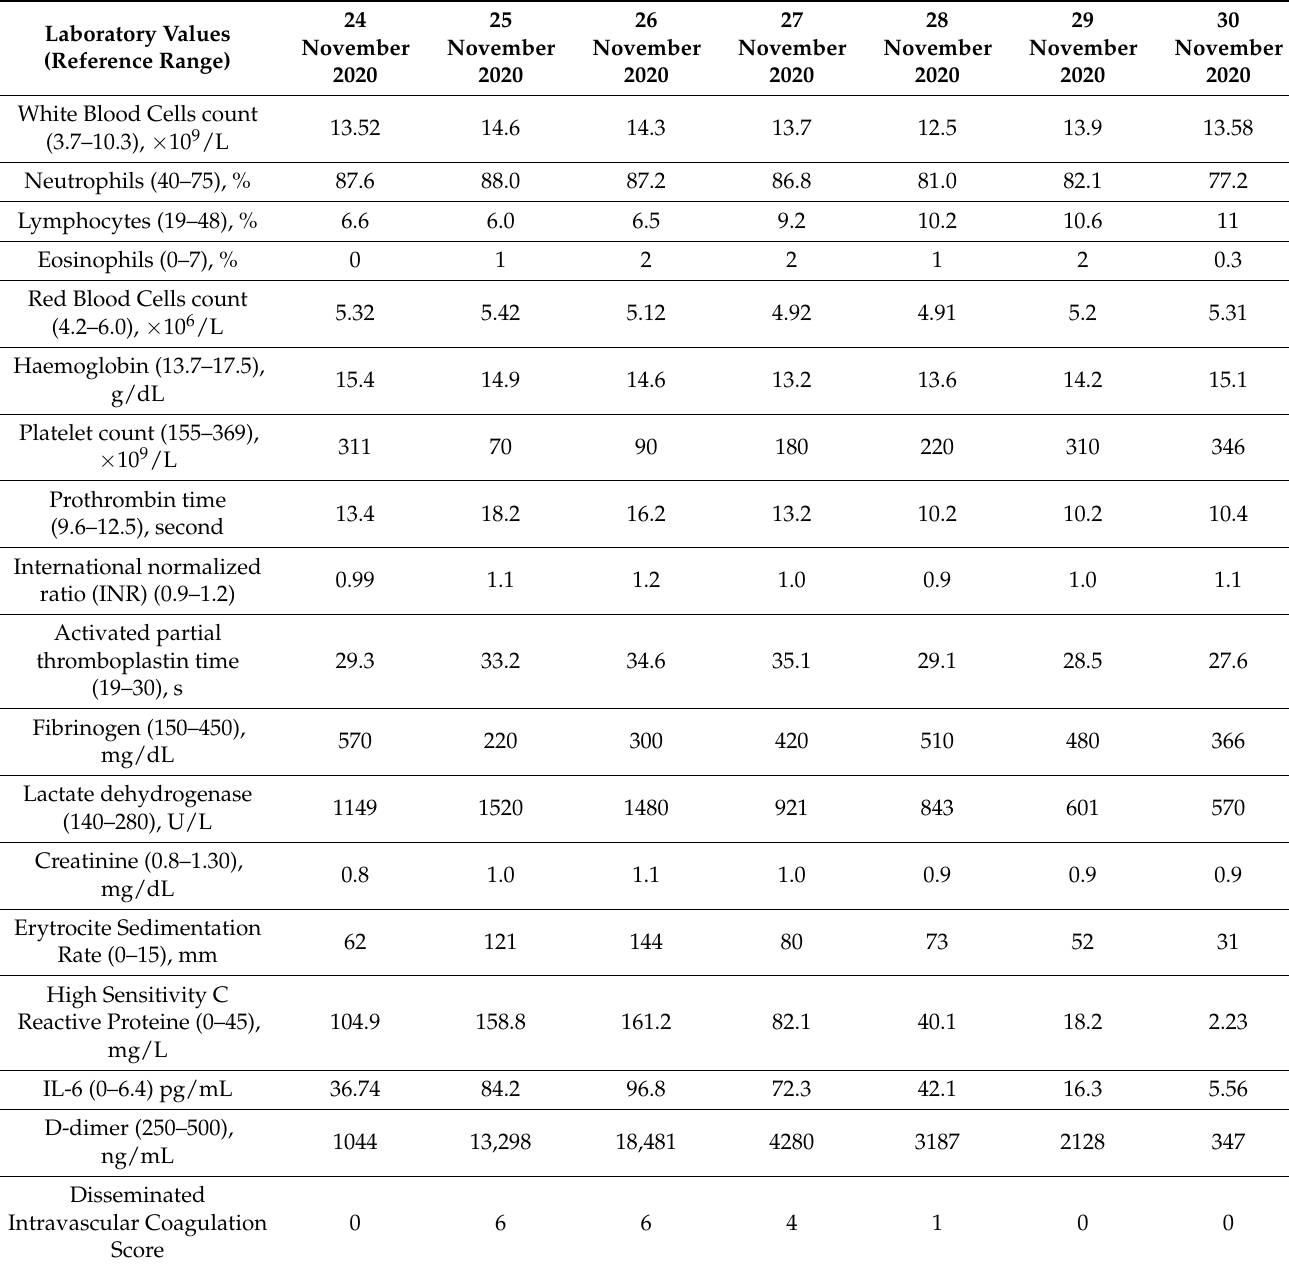
Table 1. Summary of COVID-19 Patient Laboratory